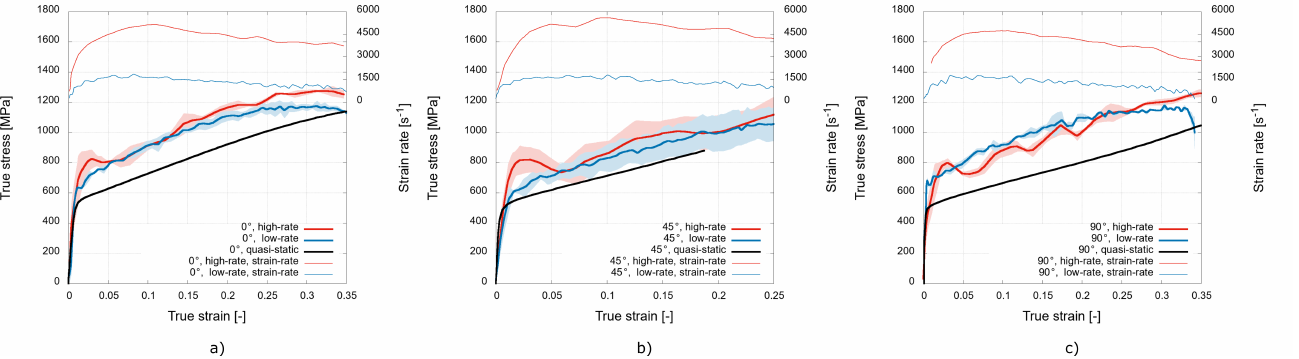
Figure 5. Mean true stress–true strain diagrams: ( a ) 0 ◦ ; ( b ) 45 ◦ ; and ( c ) 90 ◦ printing orientations.